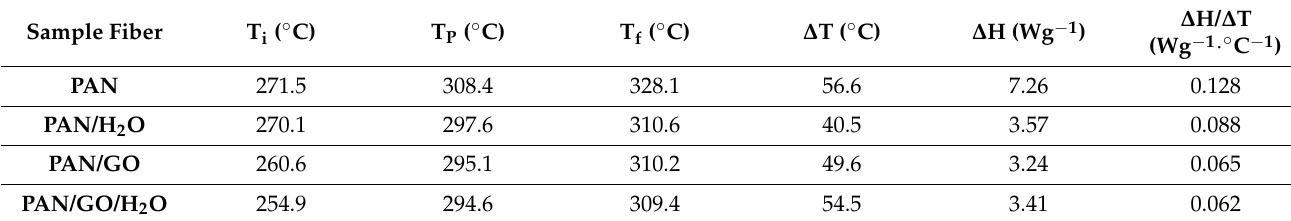
Figure 6. DSC thermograms of PAN-based fibers. Table 2. DSC parameters of PAN-based fibers.